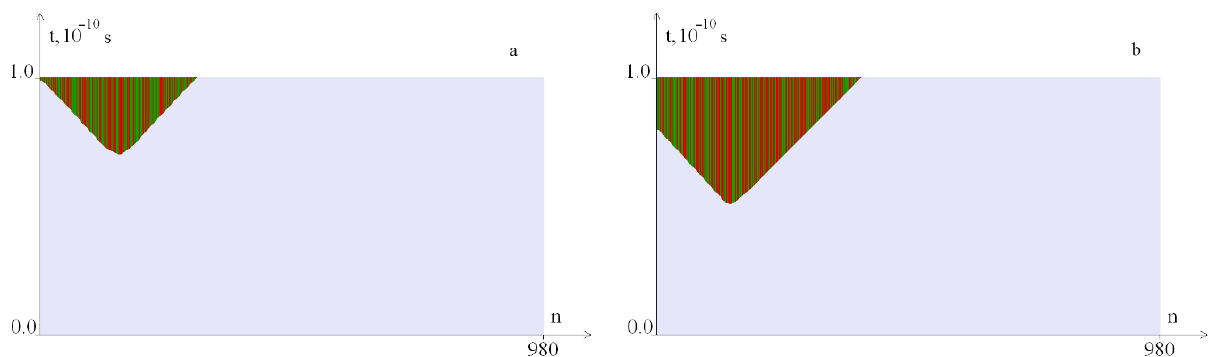
Figure 8. OS sections under the localized torque action ( M 0 : ( a )—at M 0 = 22.2, ( b )—at M 0 = 22.3) on bases 101–200. Green indicates OS in A–T pairs, red, in G–C pairs.